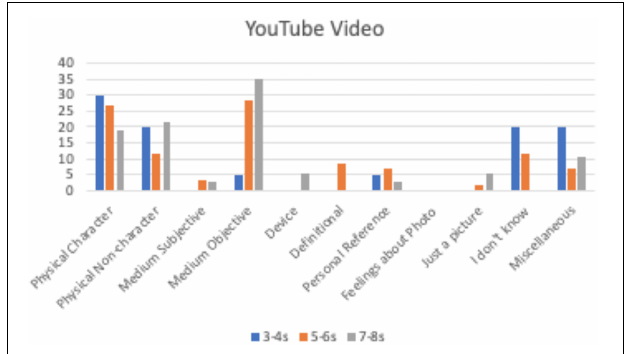
FIGURE 6 | Percentage of children by age group providing each justification for the YouTube